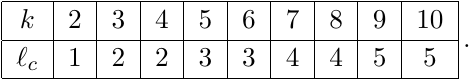
(red), m 1 (1+ n, 2+ n, 3+ n ) (blue), m 2 (1+ n, 2+ n, 3+ n ) m 3 (1+ n, 2+ n, 3+ n ) ( ‘ ) is the largest and the 1 1 , ‘ 2 , ‘ 3